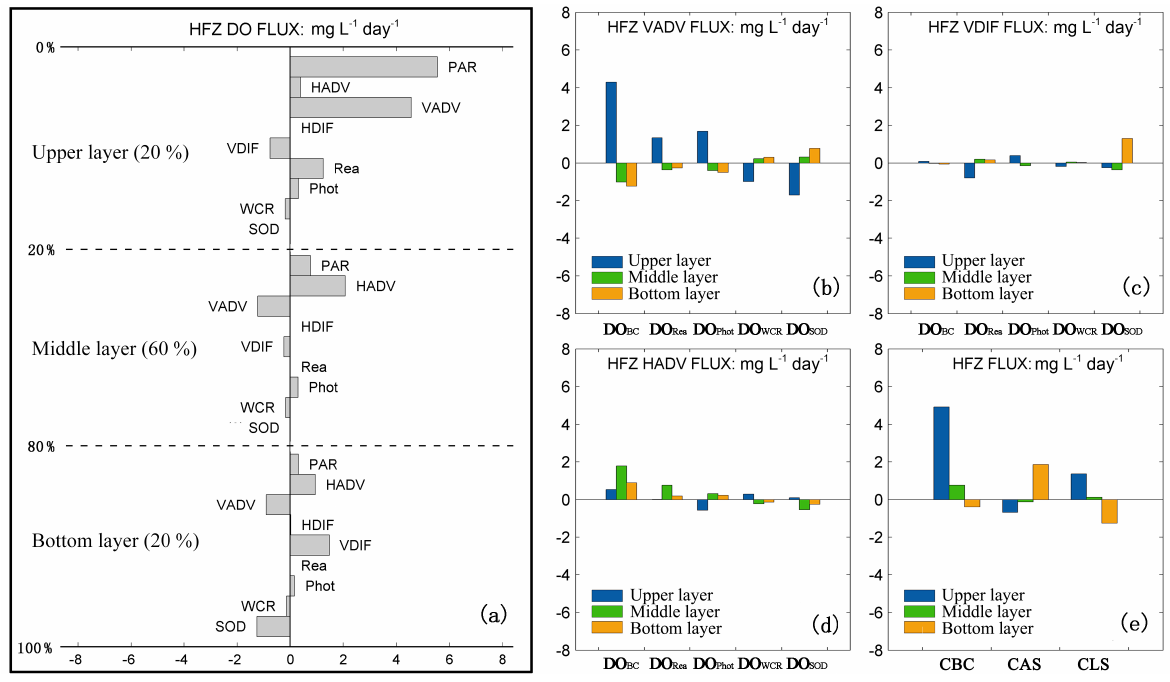
Figure 12. Same as Fig. 11 except for the